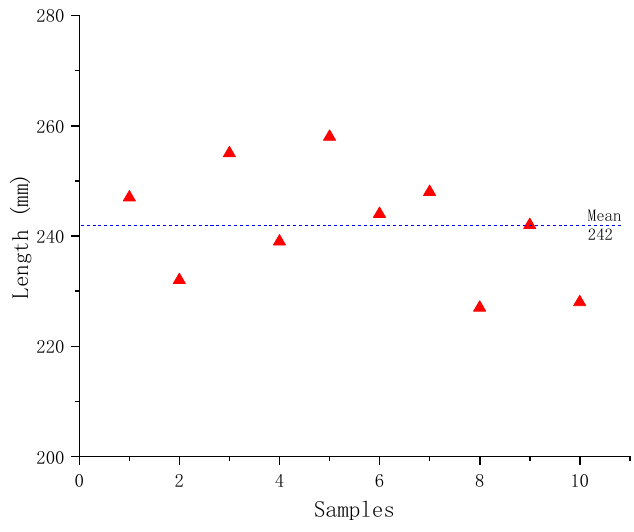
( b ) Figure 14. Relationship between depth value and camera tilt angle. ( a ) No depth difference occurred, and ( b ) depth dif- ference occurred.